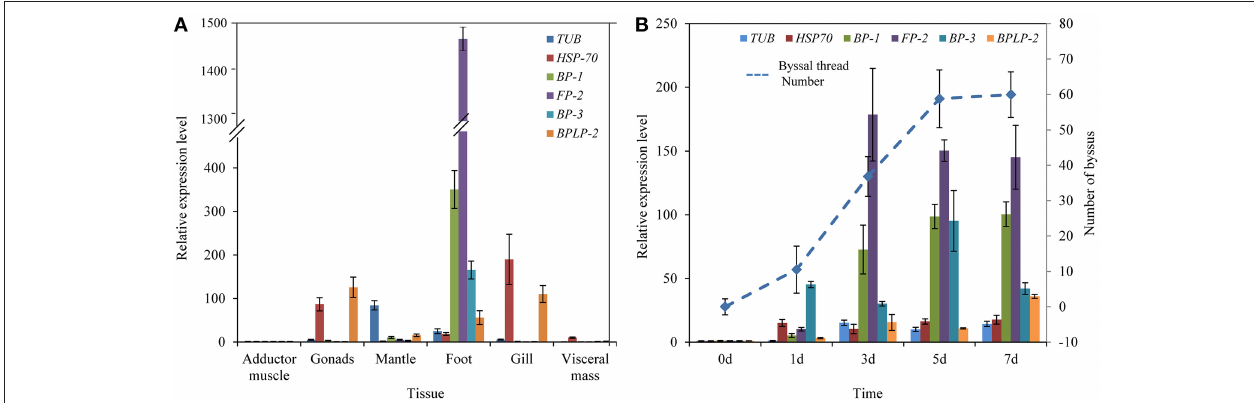
FIGURE 4 | Relative expression levels of six selective foot protein genes in different tissues (A) and byssus formation period (B) in the golden mussel Limnoperna fortunei detected by real-time quantitative PCR. TUB , Tubulin alpha chain; HSP-70 , Heat shock protein 70; BP-1 , Byssal protein-1; FP-2 , Putative foot protein-2; BP-3 , Byssal protein-3; BPLP-2 , Byssal peroxidase-like protein 2. (B) The line chart indicates the changes in byssal thread numbers.